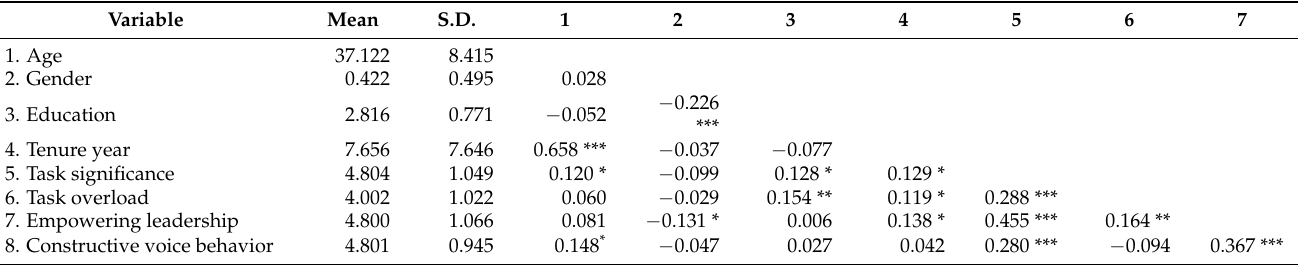
Table 3. Descriptive statistics and correlation analysis between